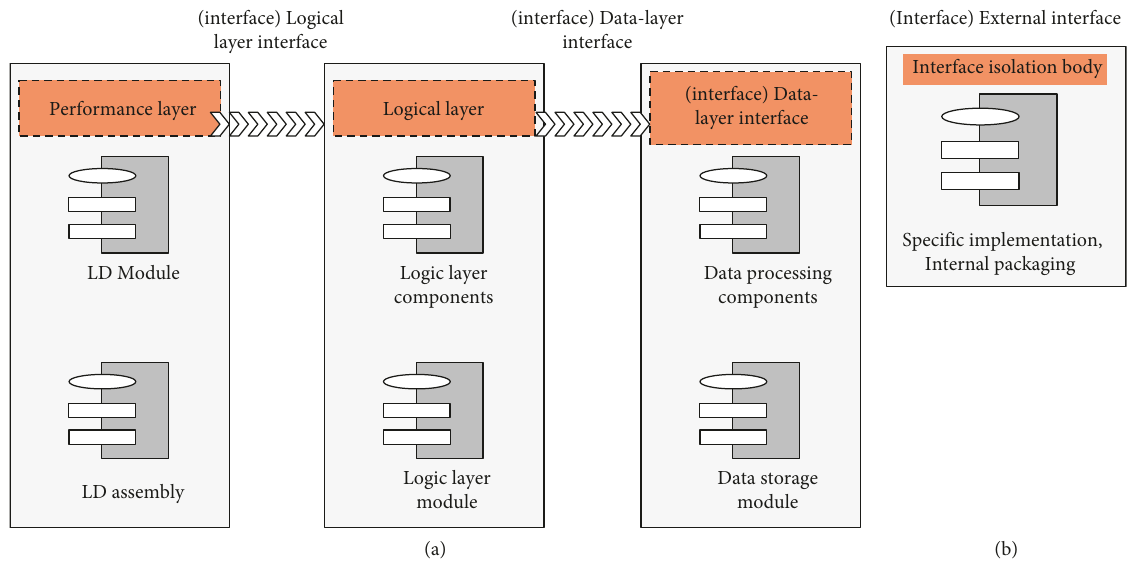
Figure 4: Layered mode: (a) overall framework and (b)